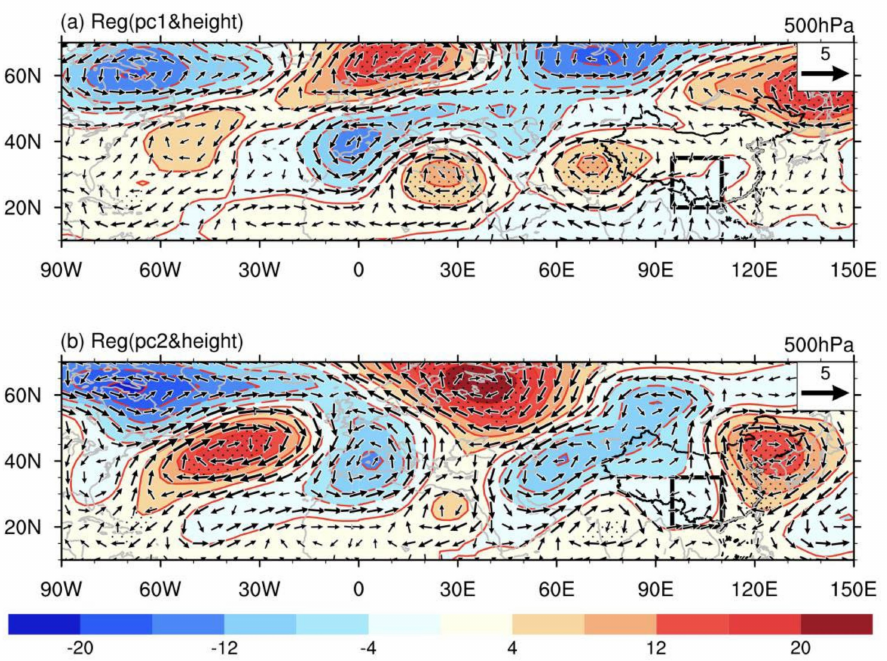
Figure 6. ( a ) Regressed anomalies of the interannual component of 500 hPa geopotential height (shaded, unit: gpm) and wind (vector, unit: ms − 1 ) onto the interannual components of the PC1 for the period of 1960 to 2018. ( b ) As in ( a ), but for PC2. The black spots denote the values have passed the 95% confidence level; the black squares represent the Southwest China (21 ◦ –33 ◦ N, 97 ◦ –110 ◦